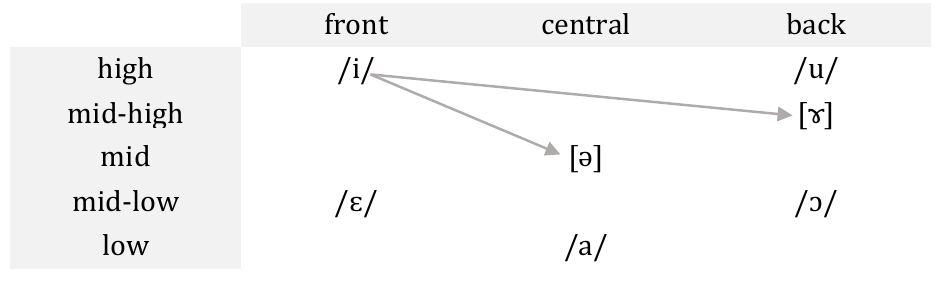
Table 5 : The emergence of /ə/ and /ɤ/ in